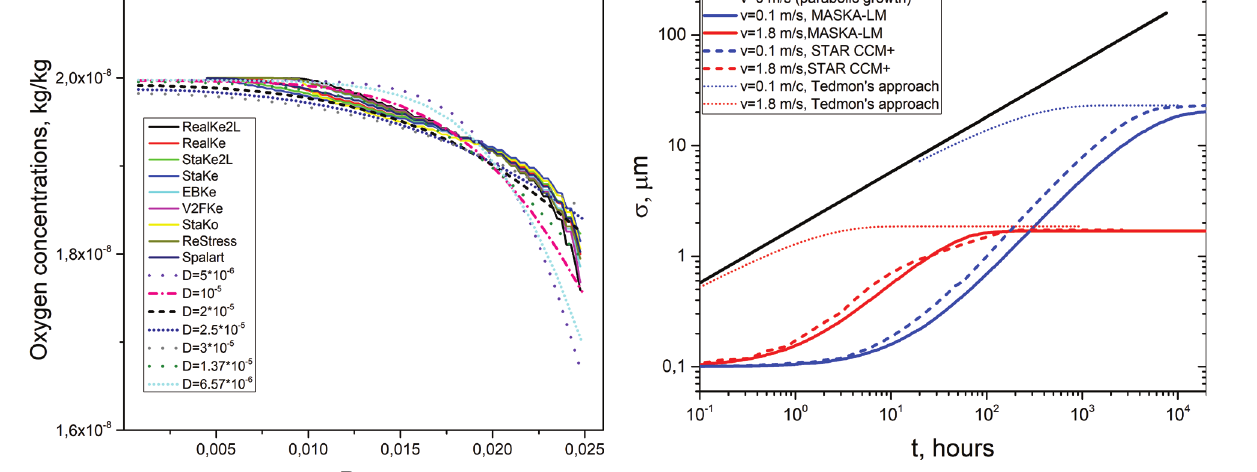
Figure 14. Results of calculations of film growth carried out with MASKA-LM, STAR-CCM+ and the solution of the Ted - mon’s approach at a temperature of T = 650 o C. Mass oxygen concentration - 10 -8 kg/kg.